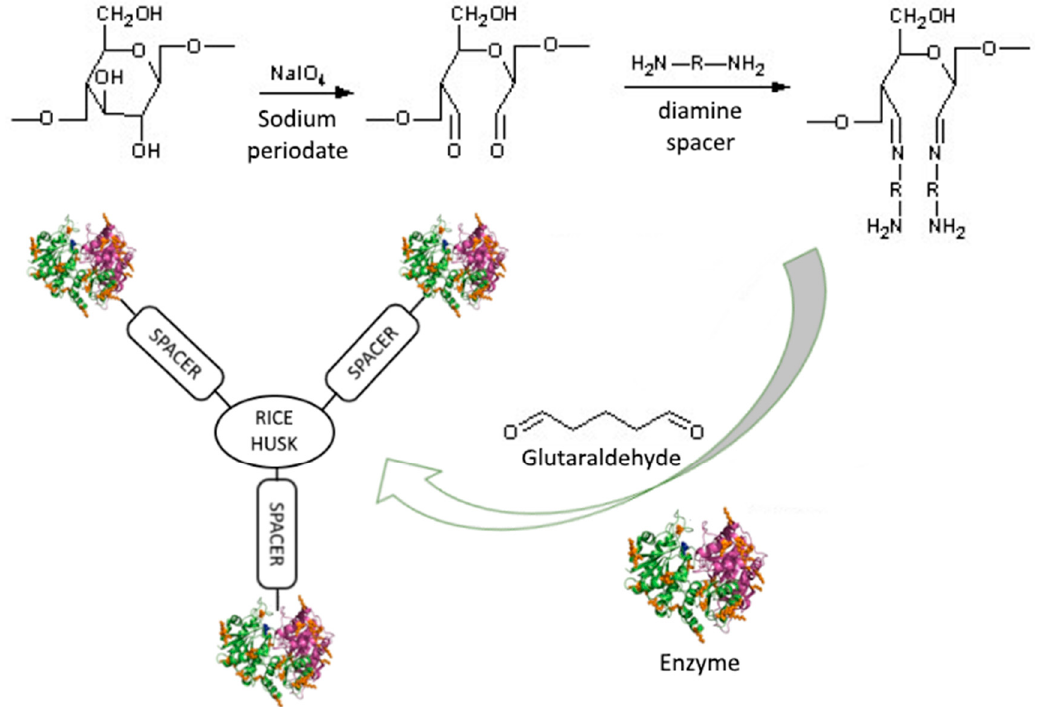
Figure 7. Schematic illustration of the oxidation and functionalization of the cellulosic fraction of RH for the covalent immobilization of CaLB.